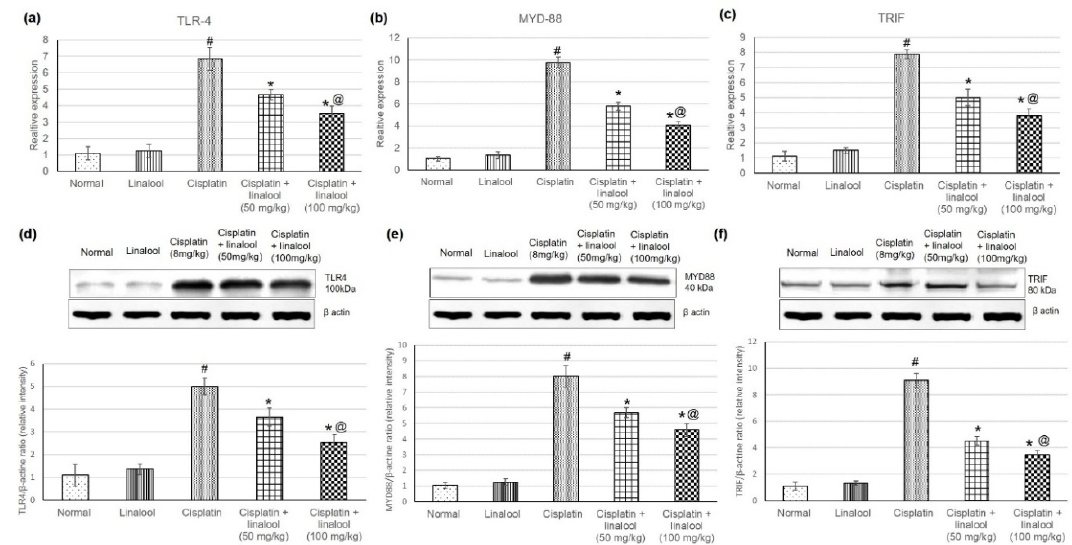
Figure 3. Effects of pre-treatment with linalool (50 and 100 mg/kg) for 14 days on the TLR pathway gene expression (mRNA amplification) ( a ) TLR4, ( b ) MyD88, and ( c ) TRIF, and TLR pathway proteins’ expression ( d ) TLR4, ( e ) MYD88, and ( f ) TRIF in cisplatin-induced acute kidney injury. All values are expressed as mean ± SD. # indicates statistically significant compared with the normal control group, * indicates statistically significant from the cisplatin-only group, and @ indicates statistically significant from the cisplatin + linalool 50 mg/kg group ( p < 0.05) using one-way ANOVA followed by Tukey’s post-hoc analysis.